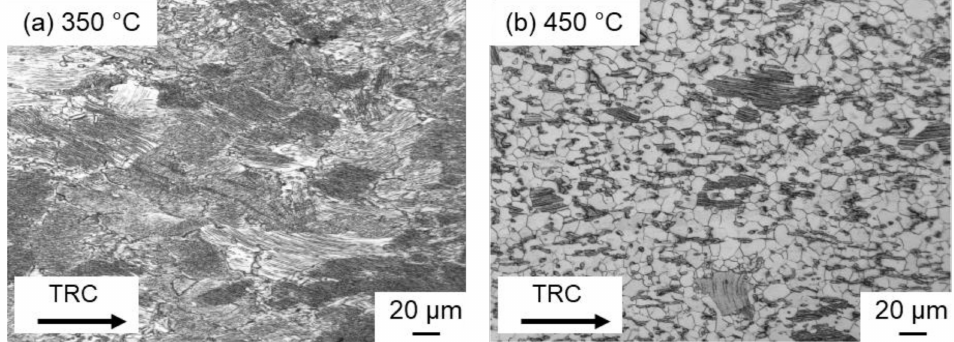
Figure 11. Optical micrographs of the deformed samples after twin-roll casting compressed at different temperatures ( a ) 350 ◦ C and ( b ) 450 ◦ C and a strain rate of 10 s − 1